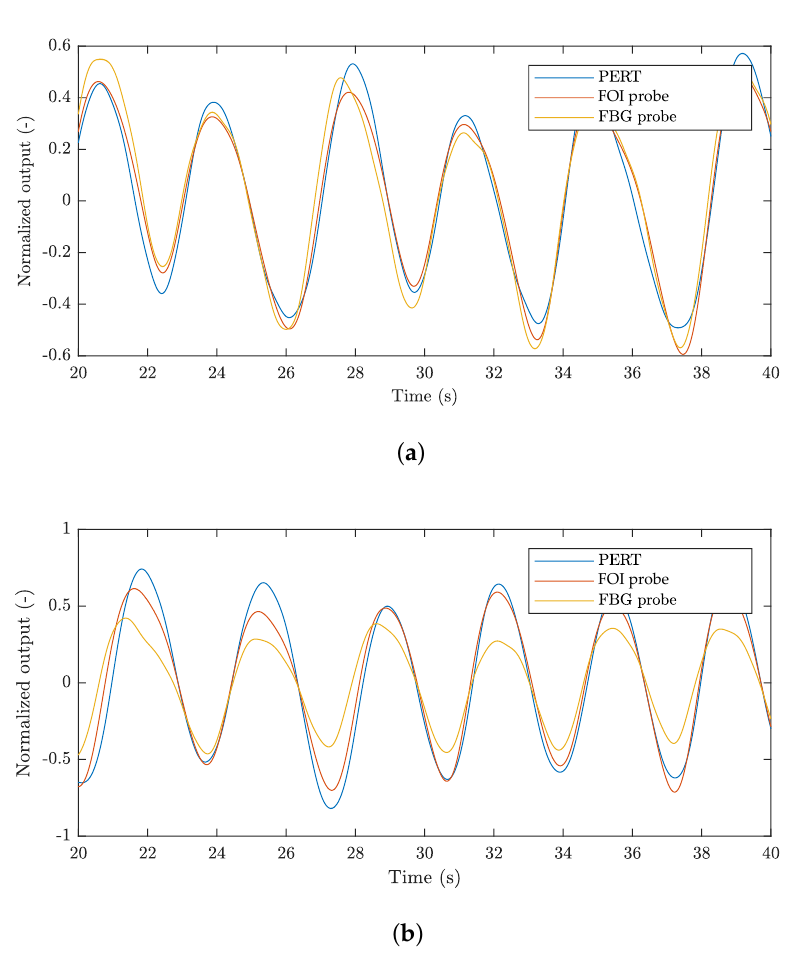
Figure 11. ( a ) an example of filtered signals representing the respiratory activity of subject M1; ( b ) an example of filtered signals representing the respiratory activity of subject